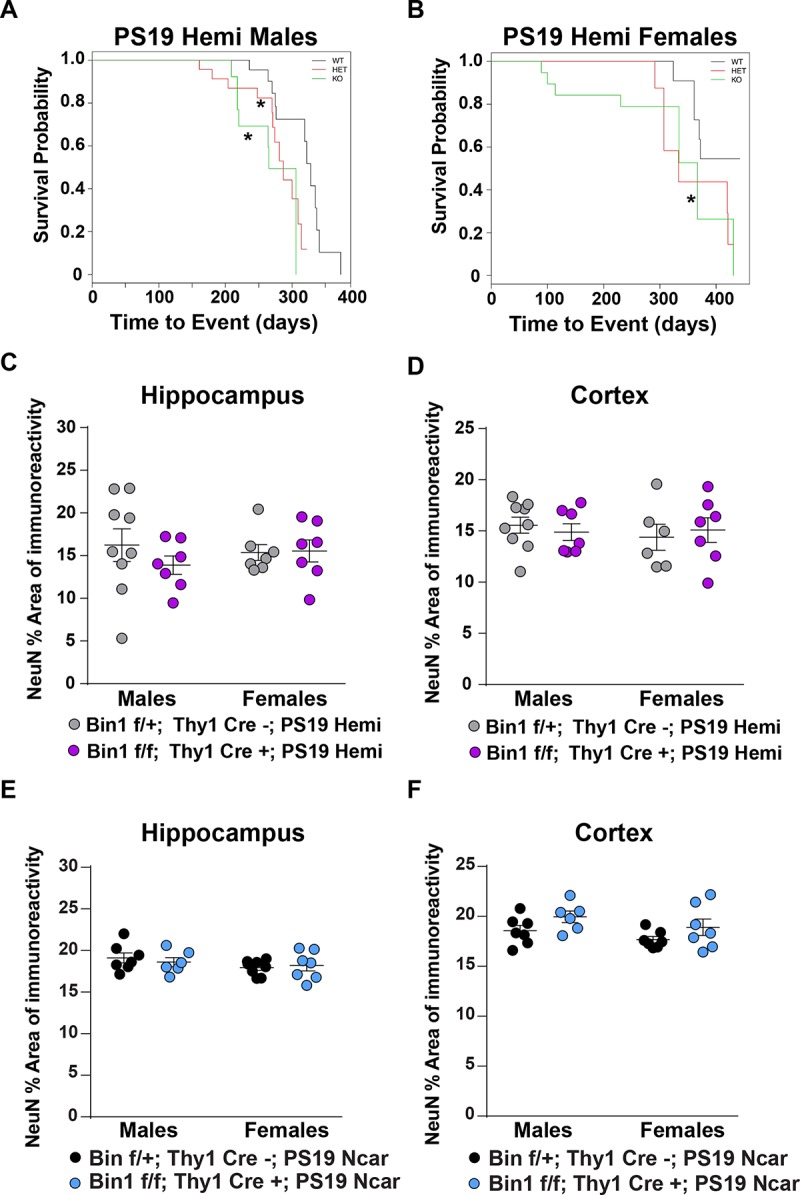
Genetic deletion of Bin1 in neurons leads to a reduction in survival but not to neuronal loss in PS19 Hemi or Ncar mice.(A) Male Bin1flox/flox:: Thy1-Cre+:: PS19Hemi mice (KO, green line) and Bin1flox/+::Thy1-Cre+::PS19Hemi (HET, red line) show reduced survival probability relative to Bin1flox/+::Thy1-Cre-::PS19Hemi (WT, black line) mice. Mean time to death WT: 328 days, HET: 287 days (p = 0.029), KO: 265 days (p = 0.029) (Kaplan Meier adjusted p-value (adj), relative to WT). Adjusted p-value: * p< 0.05; ** <0.01; *** p<0.001. (B) Female Bin1flox/flox:: Thy1-Cre+:: PS19Hemi mice (KO, green line) show reduced survival probability relative to Bin1flox/+::Thy1-Cre-::PS19Hemi (WT, black line) mice. Mean time to death WT: not calculated as greater than 50% remained alive at experimental end point, HET: 333 days (p = 0.097), KO: 367 days (p = 0.017) (Kaplan Meier adjusted p-value, relative to WT). Adjusted p-value: * p< 0.05; ** <0.01; *** p<0.001. (C) Plot representing the percentage of NeuN staining area in sections from the hippocampus of male and female Bin1flox/+::Thy1-Cre-::PS19Hemi (gray filled circles) or Bin1flox/flox:: Thy1-Cre+:: PS19Hemi mice (purple filled circles) mice, expressed as a percentage of the total hippocampal area. Each circle represents the value from one animal. (D) Plot representing the percent area of NeuN immunoreactivity in sections from the cortex of male and female Bin1flox/+:: Thy1-Cre-::PS19Hemi (gray filled circles) or Bin1flox/flox:: Thy1-Cre+:: PS19Hemi mice (purple filled circles) mice, expressed as a percentage of the total cortical area. Each circle represents the value from one animal. (E) Plot representing the percent area of NeuN immunoreactivity in sections from the hippocampus of male and female Bin1flox/+:: Thy1-Cre-::PS19Ncar (black filled circles) or Bin1flox/flox:: Thy1-Cre+:: PS19Ncar mice (blue filled circles) mice, expressed as a percentage of the total hippocampal area. Each circle represents the value from one animal. (F) Plot representing the percent area of NeuN immunoreactivity in sections from the cortex of male and female Bin1flox/+:: Thy1-Cre-::PS19Ncar (black filled circles) or Bin1flox/flox:: Thy1-Cre+:: PS19Ncar mice (blue filled circles) mice, expressed as a percentage of the total cortical area. Each circle represents the value from one animal. PS19Ncar mice age: 12–14 months old. PS19Hemi mice age: 8–9 month-old. As the PS19Hemi mice and the PS19Ncar mice were sampled at different ages, due to high mortality in the PS19Hemi line, no statistical comparisons were made between these two genotypes. Instead, the effect of Bin1 genotype was analyzed within genders within each PS19 genotype, as well as any interactions between Bin1 genotype and gender. (C) (D) (E) (F) 2-way ANOVA with interaction with single-step corrected p-values. Results presented in C, D, E and F don’t show statistically significant difference.